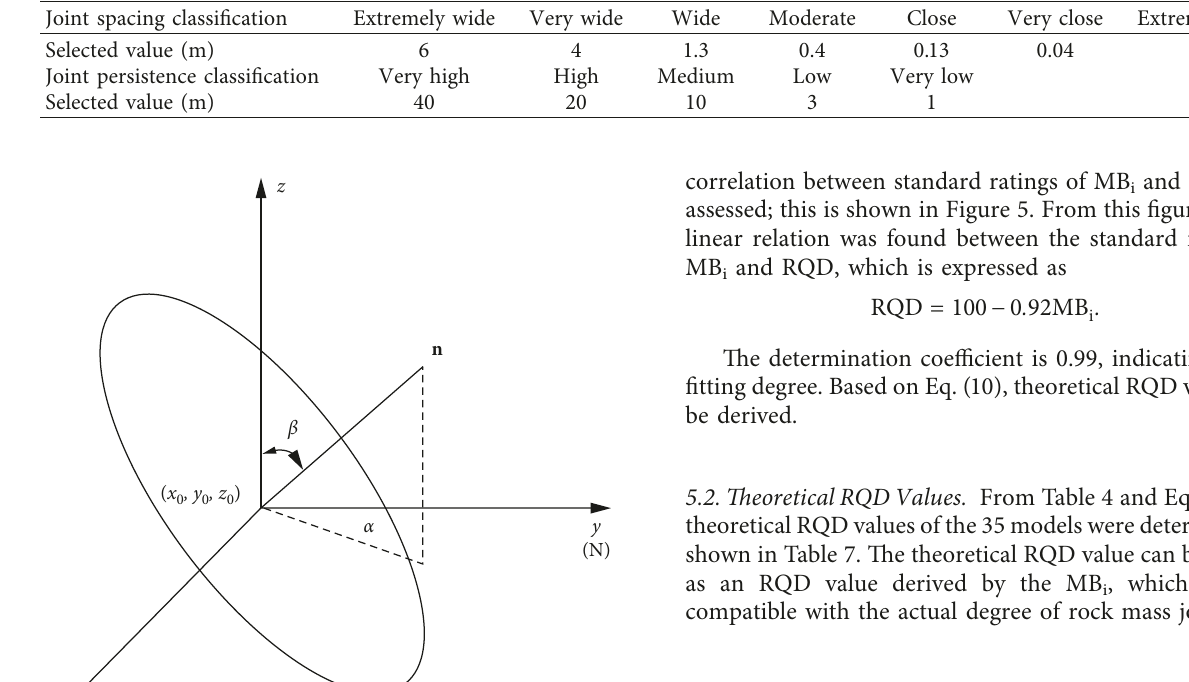
Table 1: Selected representative values of joint spacing and persistence.